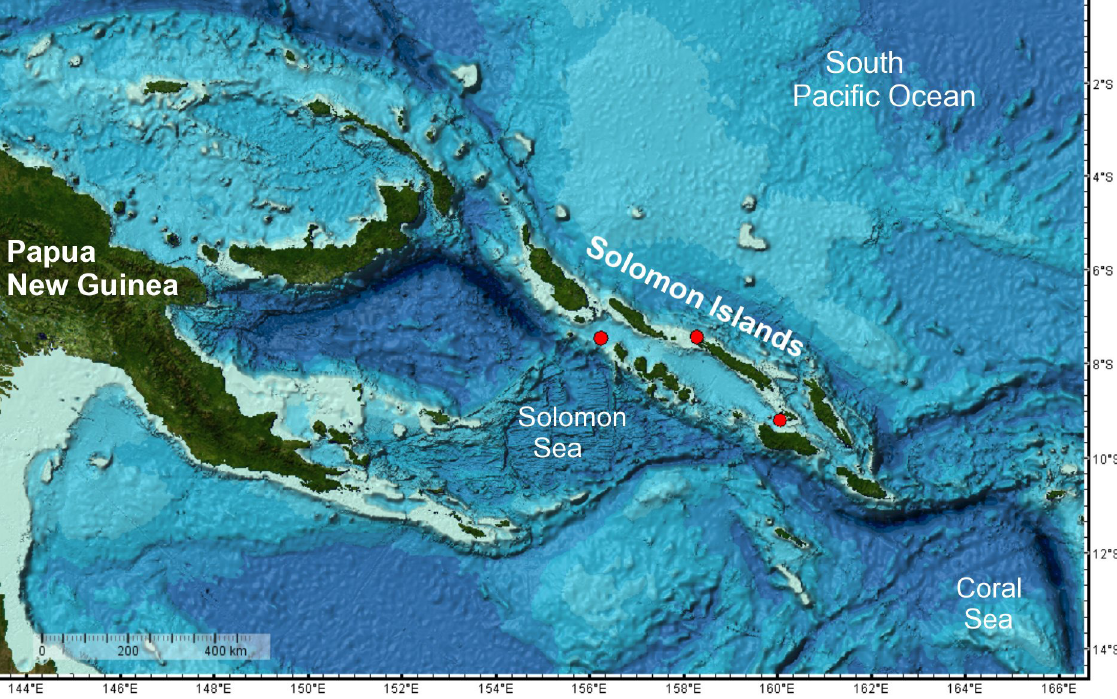
Fig. 8. Distribution map for Profundiconus maribelae sp. nov. Red circles indicate the points where the species has been